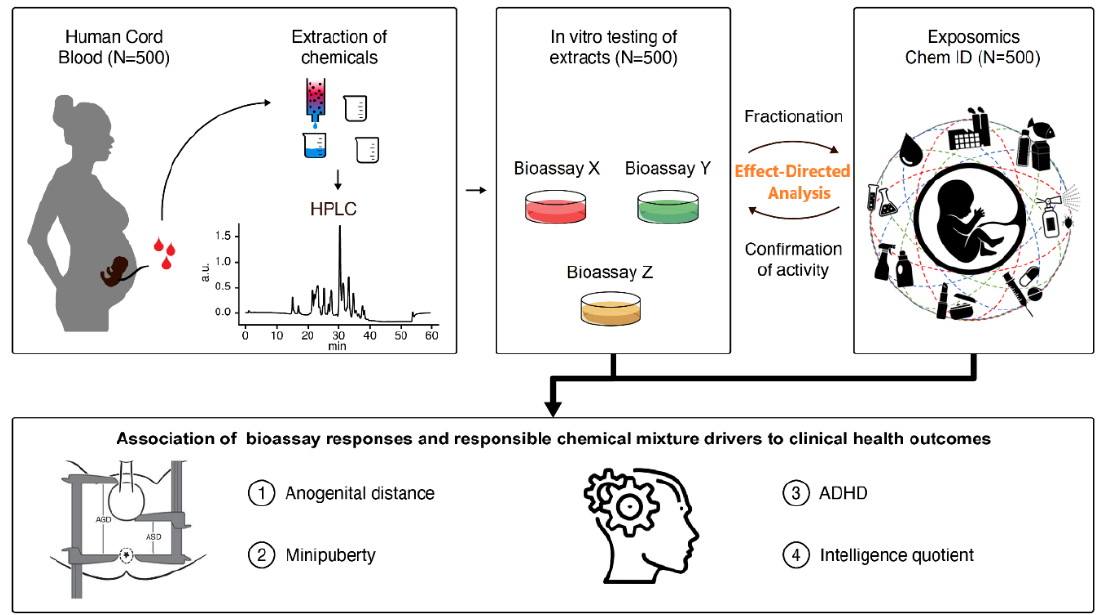
Figure 4. Illustration of the approach for the identification of a potential correlation between whole mixture ‐ based in vitro outcomes and identified chemical mixture drivers in human cord blood samples and reproductive and neuropsychological health outcomes in children. ADHD: attention deficit hyperactivity disorder.